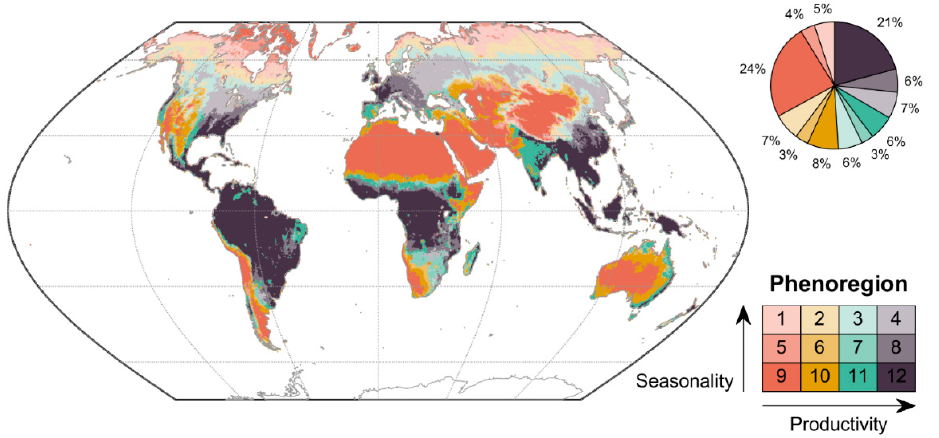
Figure 4. Global distribution of the 12 Level I phenoregions based on mean monthly NDVI, SIF, and VOD. The proportion of the global land area assigned to each phenoregion is shown in the pie chart. The legend is organized in the same two-dimensional arrangement as the SOM (with mean seasonal cycles shown in Figure 3), with increasing peak productivity from left to right (shaded from red to purple) and increasing seasonality from bottom to top (shaded from darker to lighter).